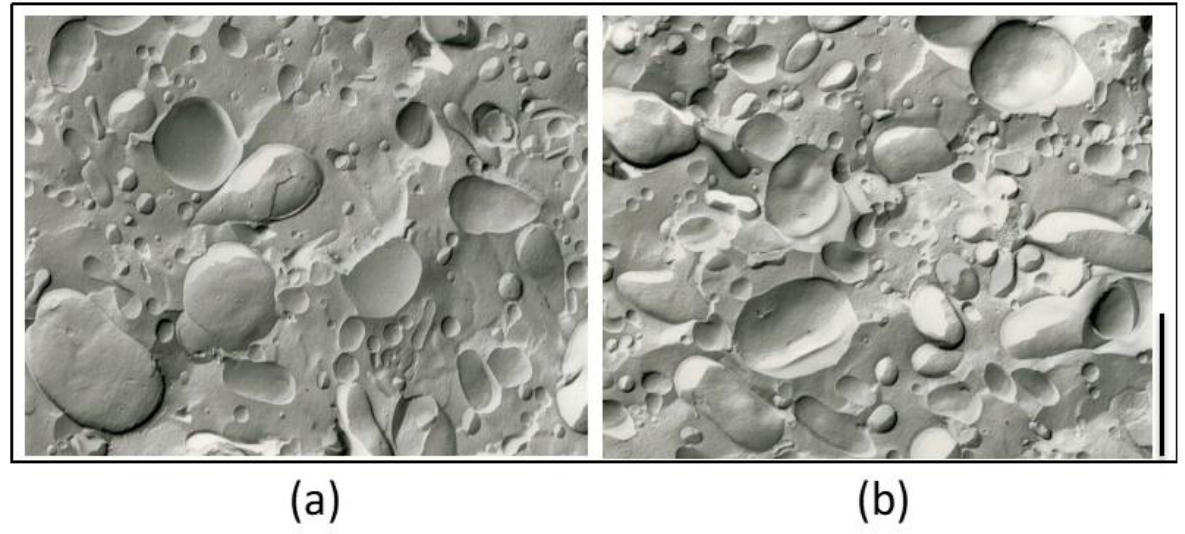
Figure 2. Freeze–fracture electron microphotographs of L ( a ) and LHC ( b ) visualized one day after production. Bar corresponds to 1.0